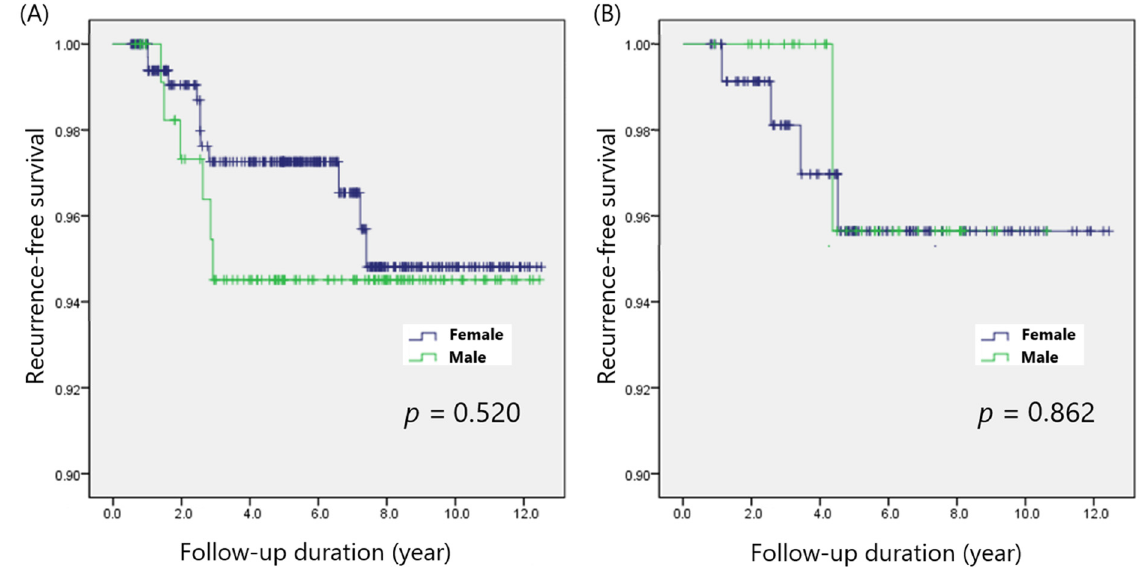
age groups (95.7% vs. 95.6%; p = 0.862) (Figure 2).